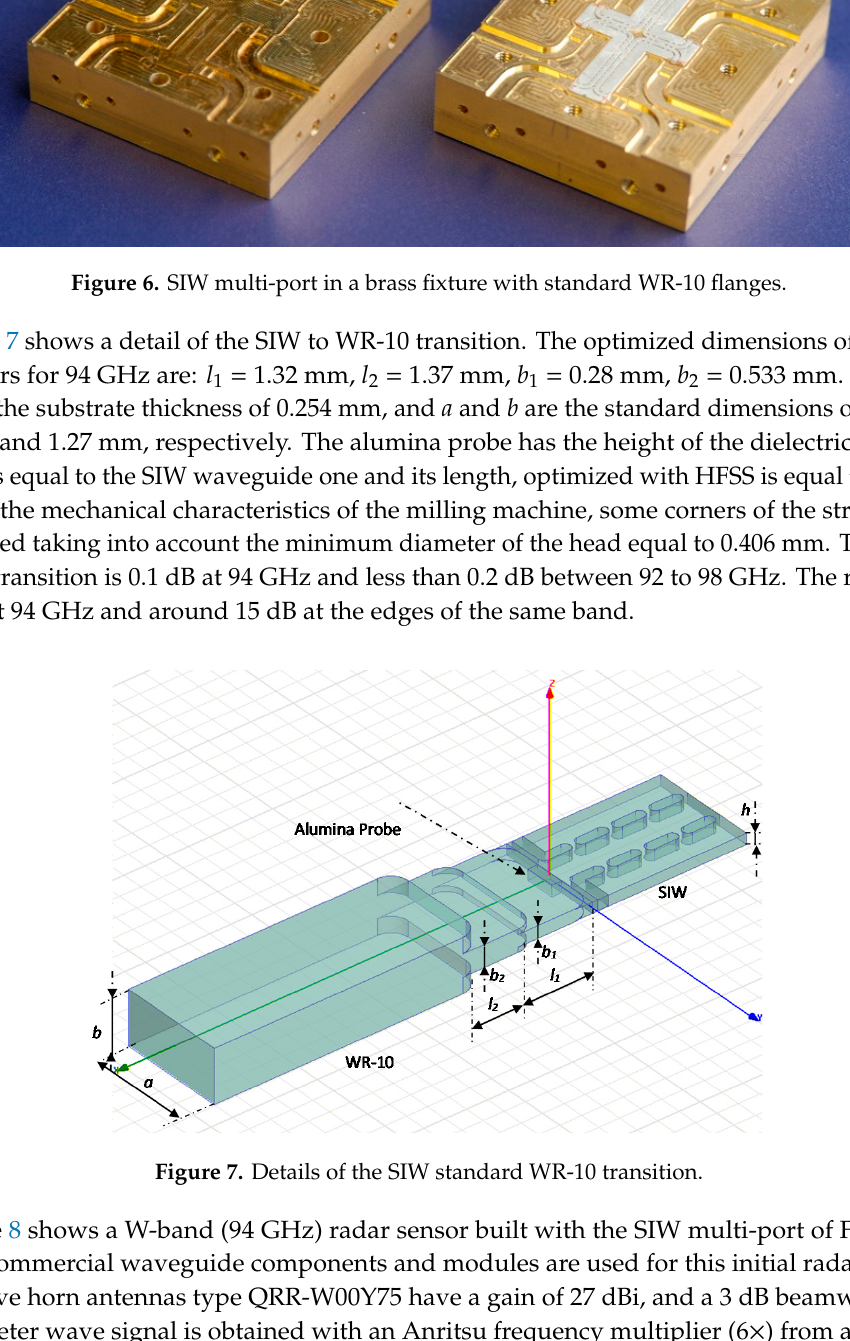
Figure 7. Details of the SIW standard WR-10 transition.